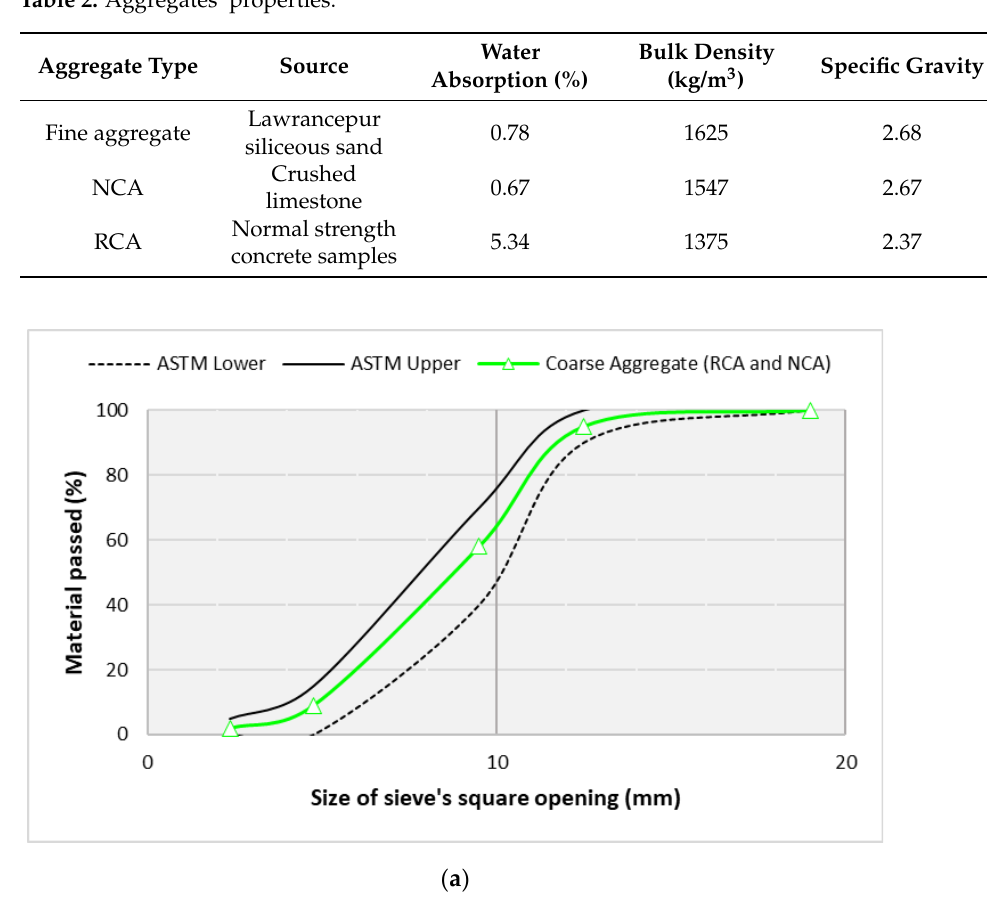
Table 2. Aggregates’ properties.